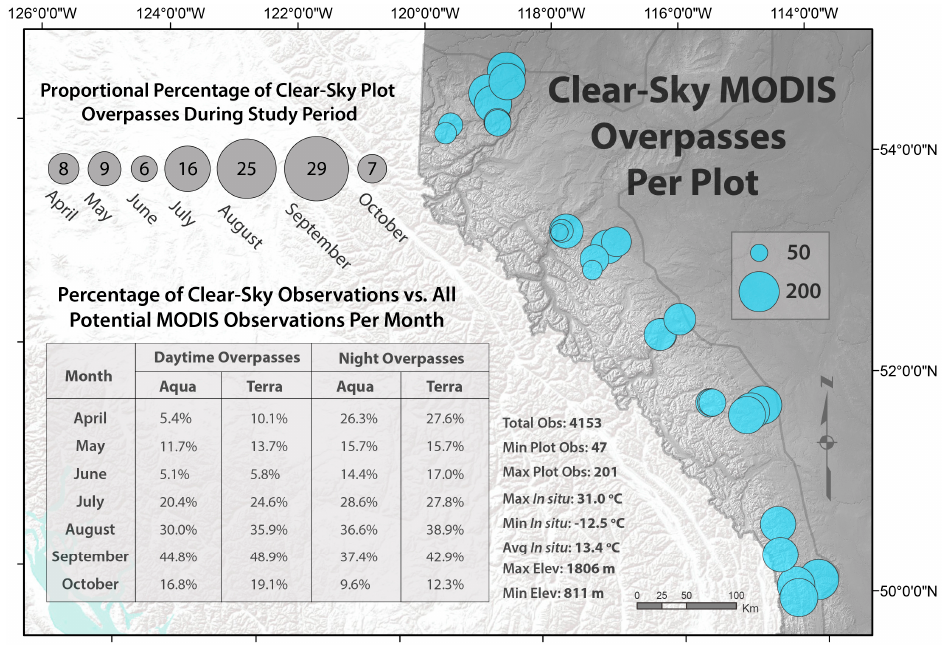
Figure 5. Spatial and temporal characteristics of the valid Moderate Resolution Imaging Spectroradiometer (MODIS) overpass dataset including spatial distribution of total clear-sky MODIS overpasses for each observation plot. Also, the proportional percentage of total clear-sky overpasses by month, and the proportional percentage of valid clear-sky observations versus all potential MODIS observations (cloud contamination) for the duration of the study period. observations (cloud contamination) for the duration of the study